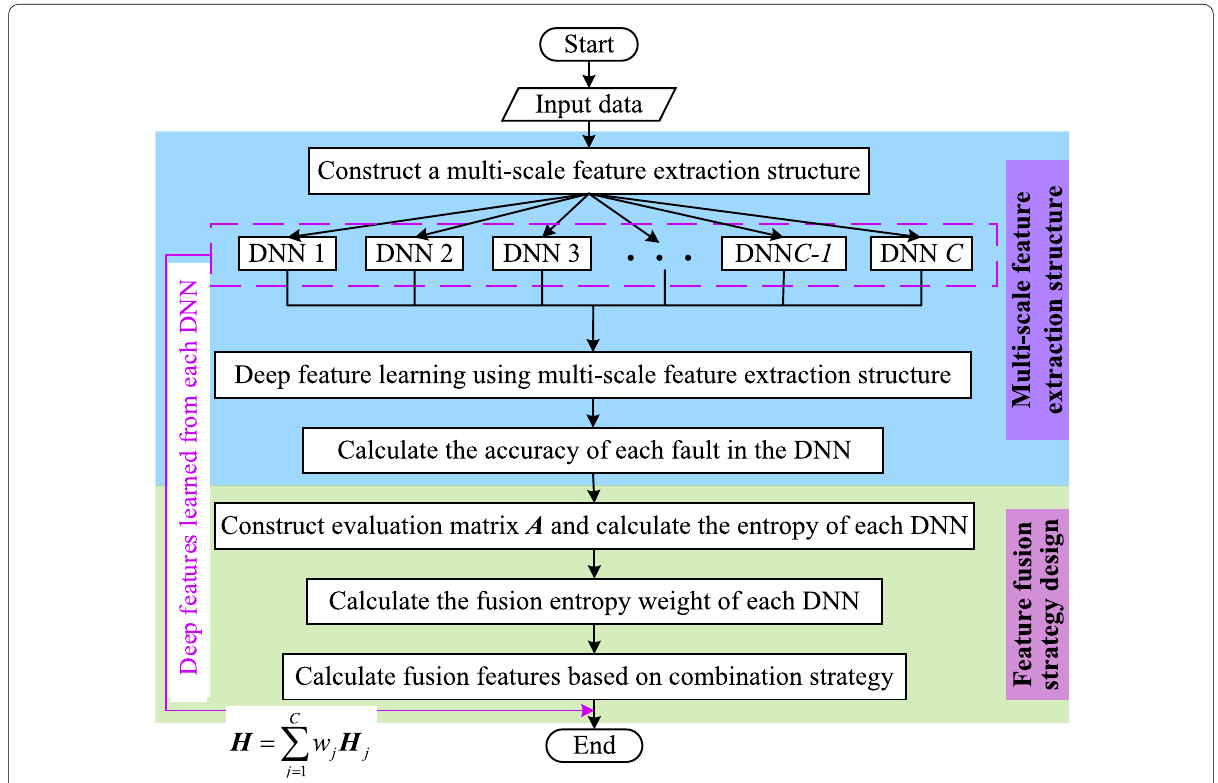
Figure 4 Algorithmic framework of feature fusion